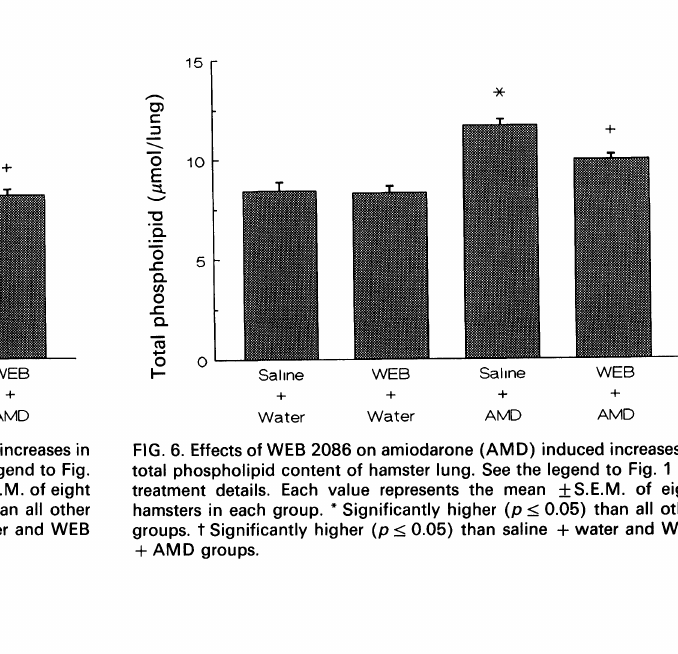
FIG. 3. Effects of WEB 2086 on amiodarone (AMD) induced increases in prolyl hydroxylase activity of hamster lungs. See the legend to Fig. for treatment details. Each value represents the mean _+S.E.M. of eight hamsters in each group. Significantly higher (p_< 0.05) than saline + water and WEB + water groups.